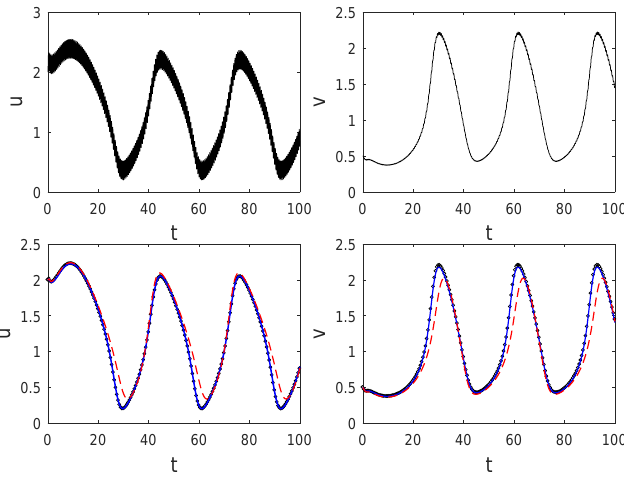
Fig. 2 The left (respectively right) panels correspond to the u (respectively v ) component of the solution. The top panels plot the true oscillatory solution as a function of t . Due to the fast oscillations of large amplitude, the graph for u appears as a solid band. The oscillations in v have a smaller amplitude; the differential equation for v does no include any periodic forcing and therefore the fast oscillations in v are only due to its coupling to u . The bottom panels give the second order averaged solution (discontinuous line) and third order averaged solution (solid line). In the bottom panels, the true solution (circles) is represented only at stroboscopic times. Clearly the third order system reproduces accurately the behaviour of the true solution (the circles are on the solid line). That is not the case if averaging is only carried out to second order. In Fig. 2, the parameters are α = 2 . 5, β = 2, A = 0 . 2, ω = 0 . 2, B = 2 . 0, Ω = 4 π and τ = 0 . 5, with